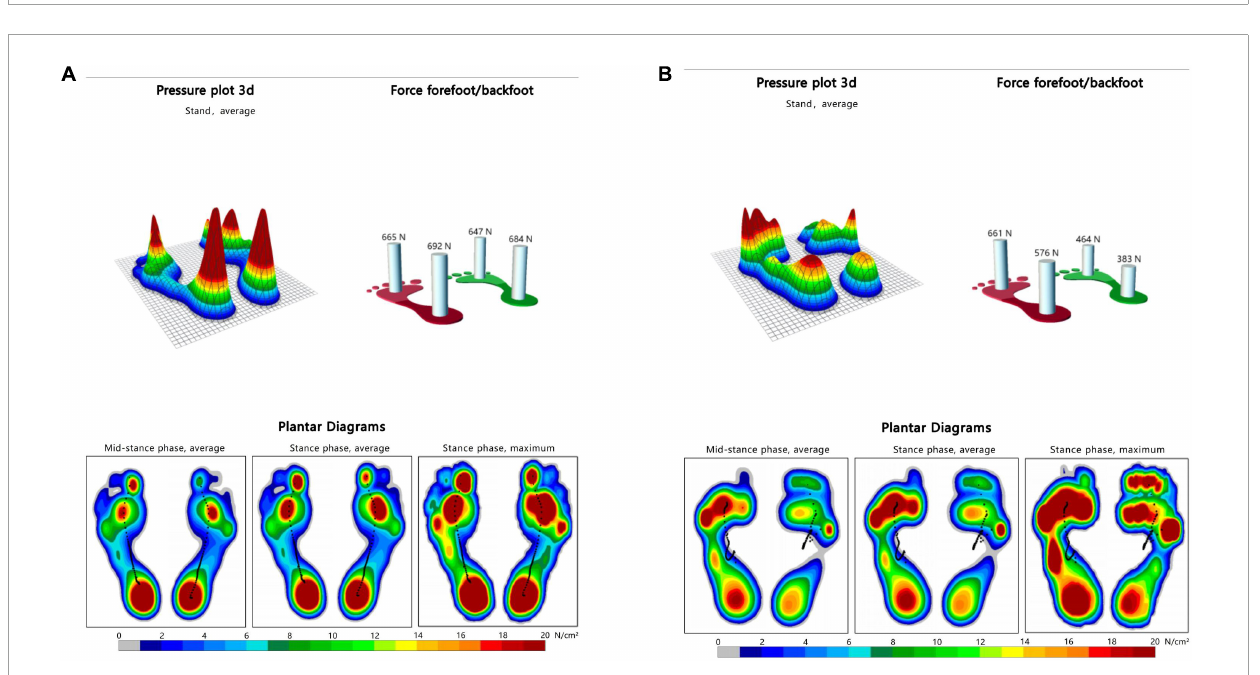
FIGURE4 Dynamic plantar pressure model diagrams in both group. When healthy people walking, the plantar pressure on both sides were evenly distributed, showing obvious symmetry (A) . While stroke patients walking, bilateral plantar pressure were unevenly distributed, showing significant asymmetry (B) . Right side is the hemiplegic side in panel (B) , and the peak plantar pressure of the forefoot and heel in the hemiplegic side were lower than those in the non-hemiplegic